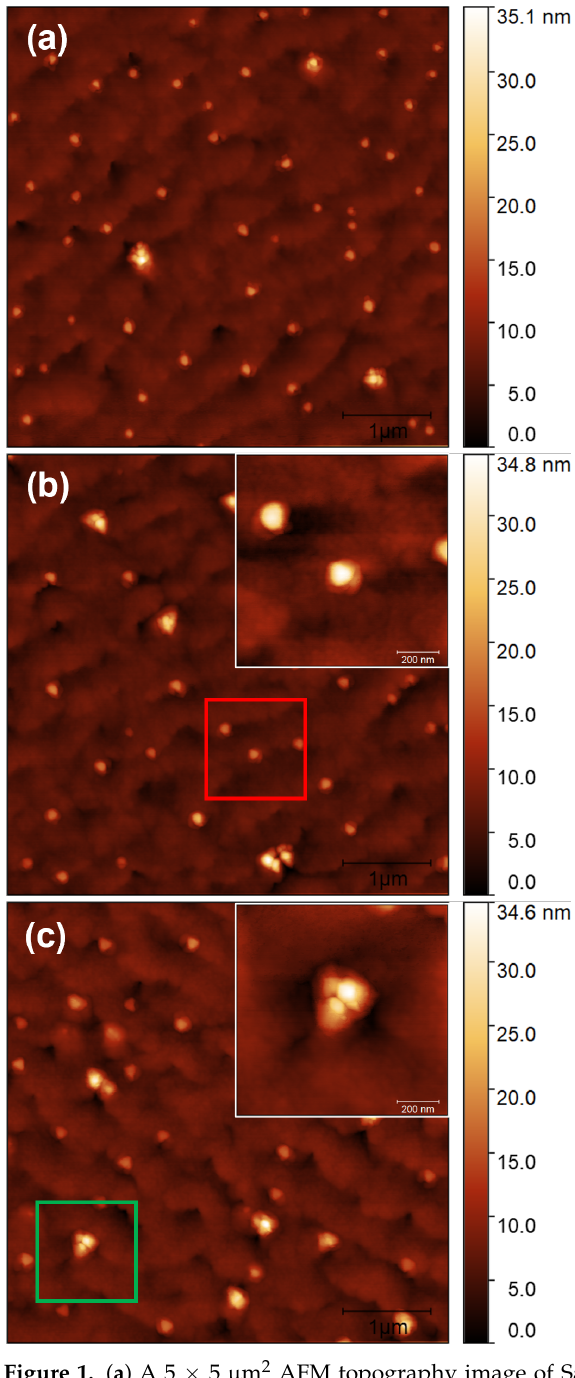
Figure 1. ( a ) A 5 × 5 µ m 2 AFM topography image of Sample S1 without any capping layer; ( b ) 5 × 5 µ m 2 AFM topography image of Sample S2 taken after the deposition of 5 nm of capping layer. (inset) A 1 × 1 µ m 2 AFM topography image relative to the red square in ( b ) Group A QDs with a truncated pyramidal shape; ( c ) 5 × 5 µ m 2 AFM topography image of Sample S3 taken after the deposition of 10 nm of capping layer. (inset) A 1 × 1 µ m 2 AFM topography image relative to the green square in ( c ) a Group B QD that was clearly